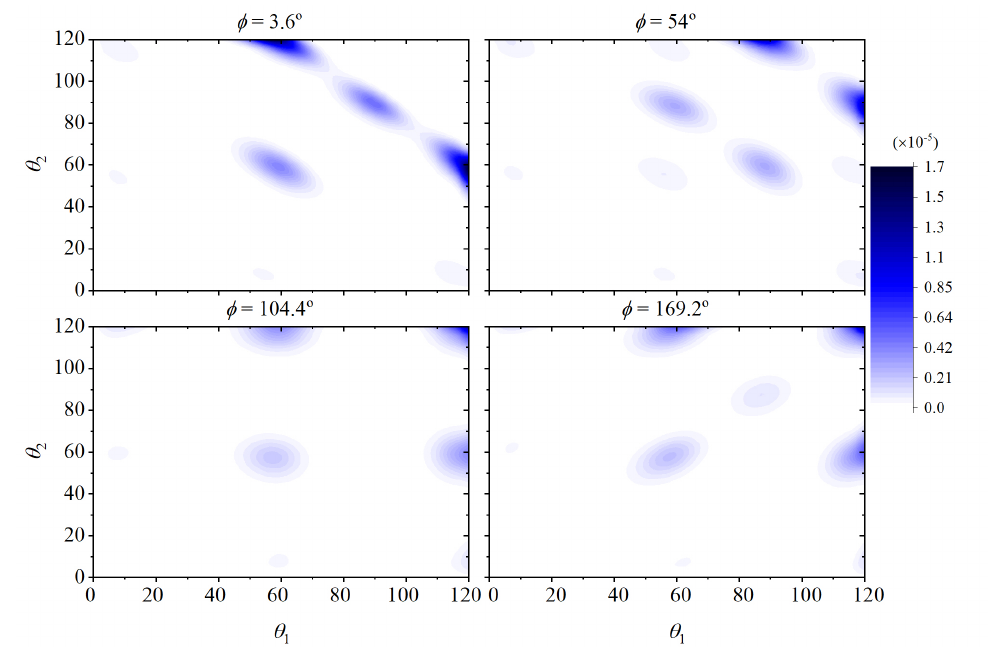
Figure 9. Sections of the joint orientational functions of bending and torsional angles in the stable ( θ ) for four values of the torsion angle φ FCC polymorph f cr 1 , φ , θ 2 bt